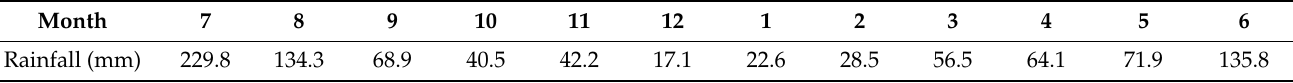
Table 1. Monthly rainfall in the study